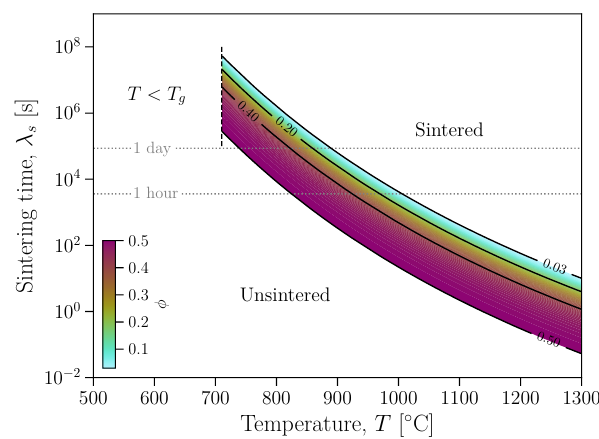
Figure 8: A guide for casting obsidian forms using a sin- tering technique, showing the time required to reach a given porosity at a given temperature. The map shown here is for 100 µ m particles in the obsidian powder, typical of normal dry milling techniques, and is com- puted using a sintering model [Wadsworth et al. 2016], which was specialized for sintering obsidian particles [Wadsworth et al. 2019b]. Typical initial packing porosi- ties of 0.5 represent the upper porosity bound, whereas the equilibrium porosity of 0.03 represents the lower bound. For casting in the ‘unsintered’ field, the result will be an unconsolidated powder of obsidian. For casting in the ‘sintered’ field, the result will be a sheet of glass with a low 0.03 porosity (e.g. Figure 1D). For the conditions of formation of ‘PEDM’, sinter-casting was performed at 1200 °C for 2 hours, which plots in the ‘sintered’ field and is consistent with the measured final porosity of φ ≈ 0.03, which is the limiting upper value for complete sintering (see Section